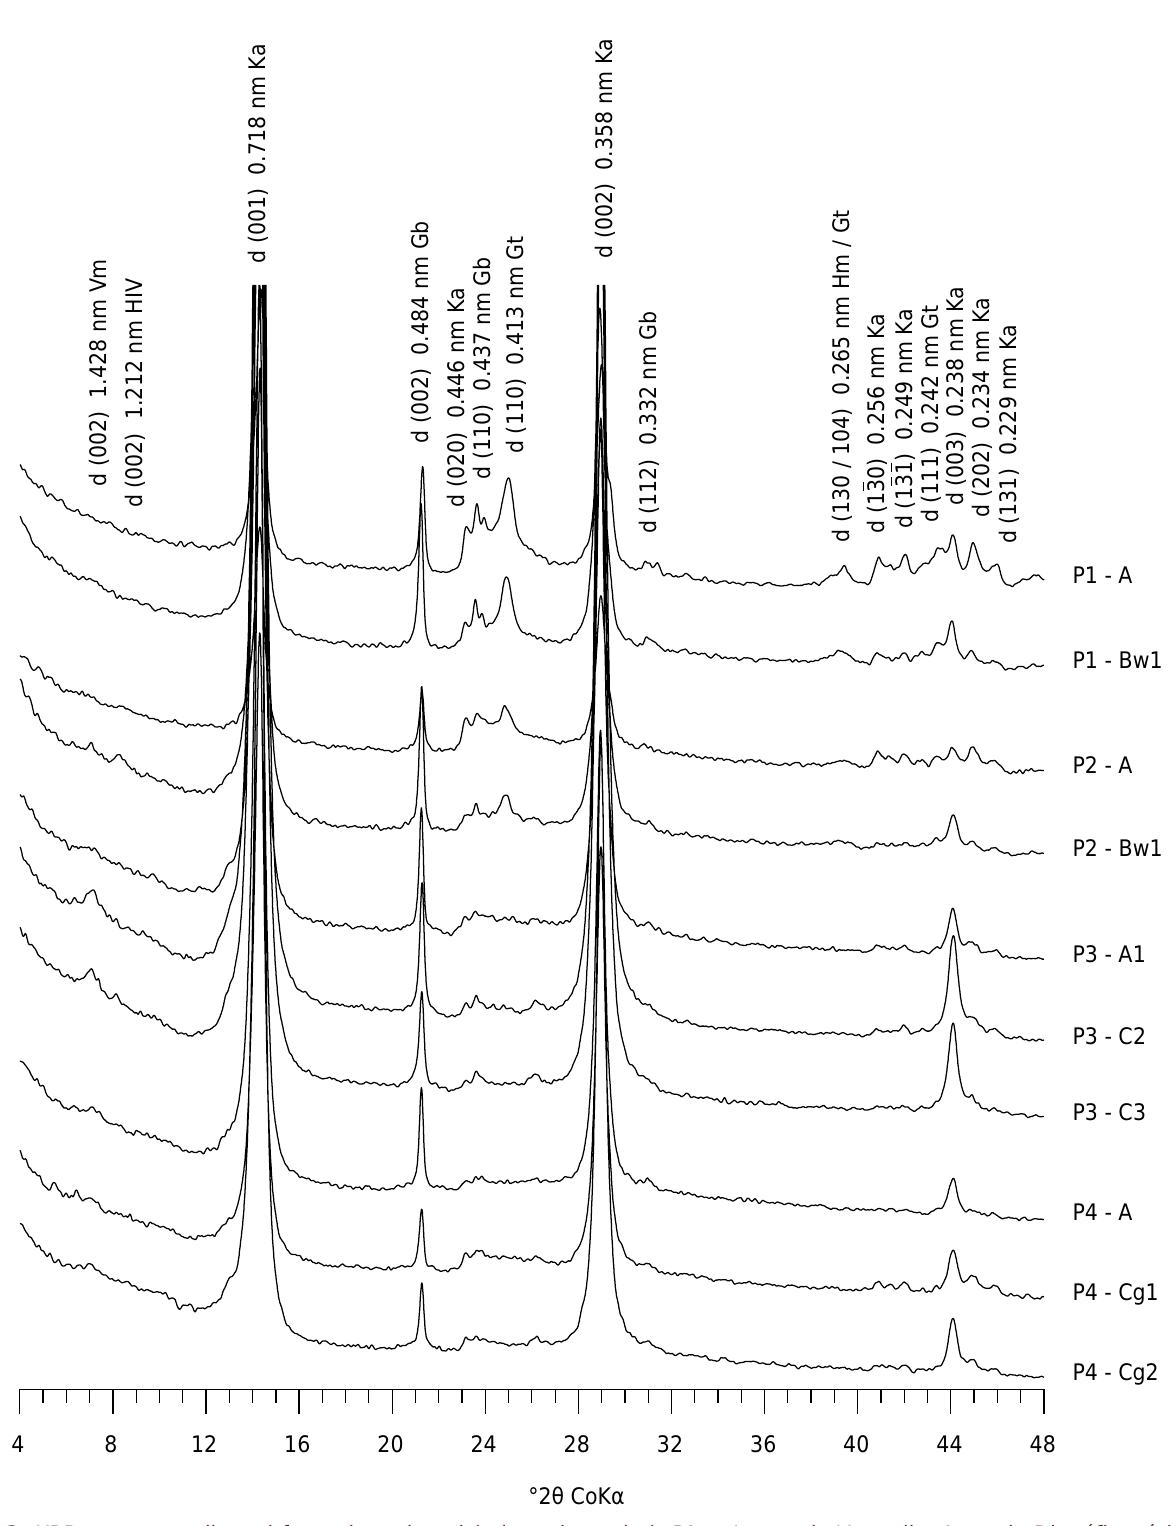
Figure 3. XRD patterns collected from clay mineral (oriented powder). P1 = Latossolo Vermelho-Amarelo Distrófico típico /Typic Acrudox; P2 = Latossolo Amarelo Distrófico típico /Typic Acrudox; P3 = Pseudogleysol; P4 = Gleissolo Háplico Distrófico típico /Typic Epiaquent; Vm = vermiculite; HIV = hydroxy-interlayered vermiculite; Ka = kaolinite; Gb = gibbsite; Gt = goethite; Hm =